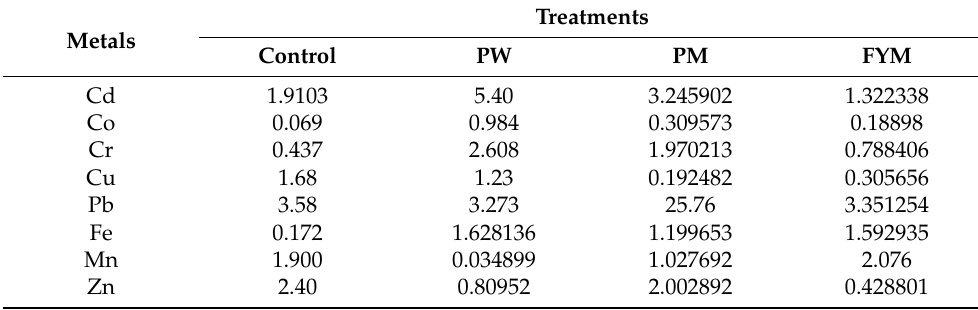
Table 3. Bioconcentration factor for A. sativum /soil.